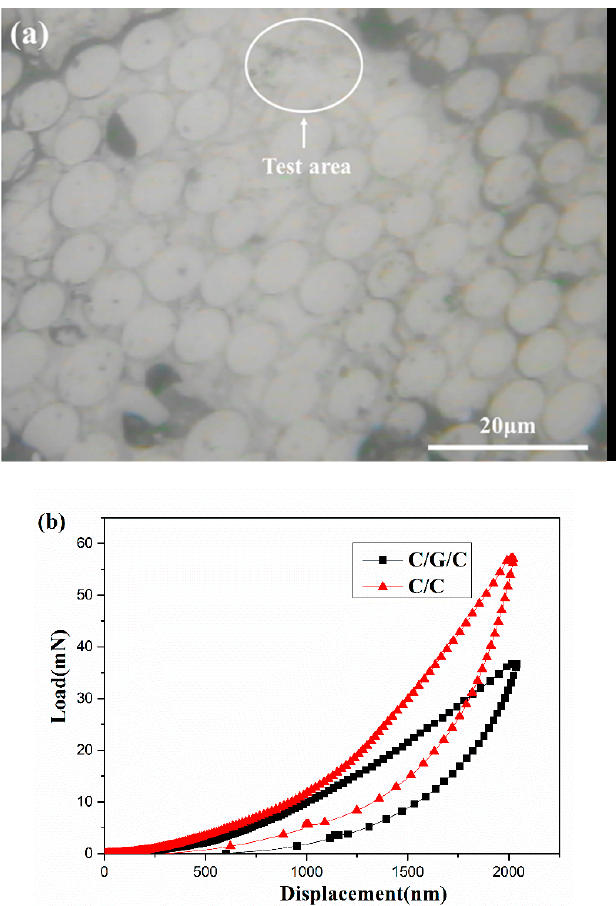
Figure 8. The nanoindentation experiments: ( a ) the microscope image of sample surface; and ( b ) typical load–displacement curves of nanoindentation of the composites.